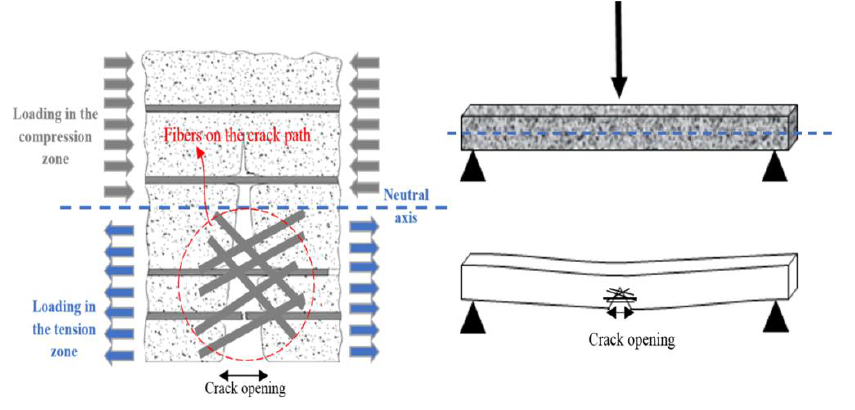
Figure 10. The efficiency of steel fibers with regard to the ability to bridge crack openings.